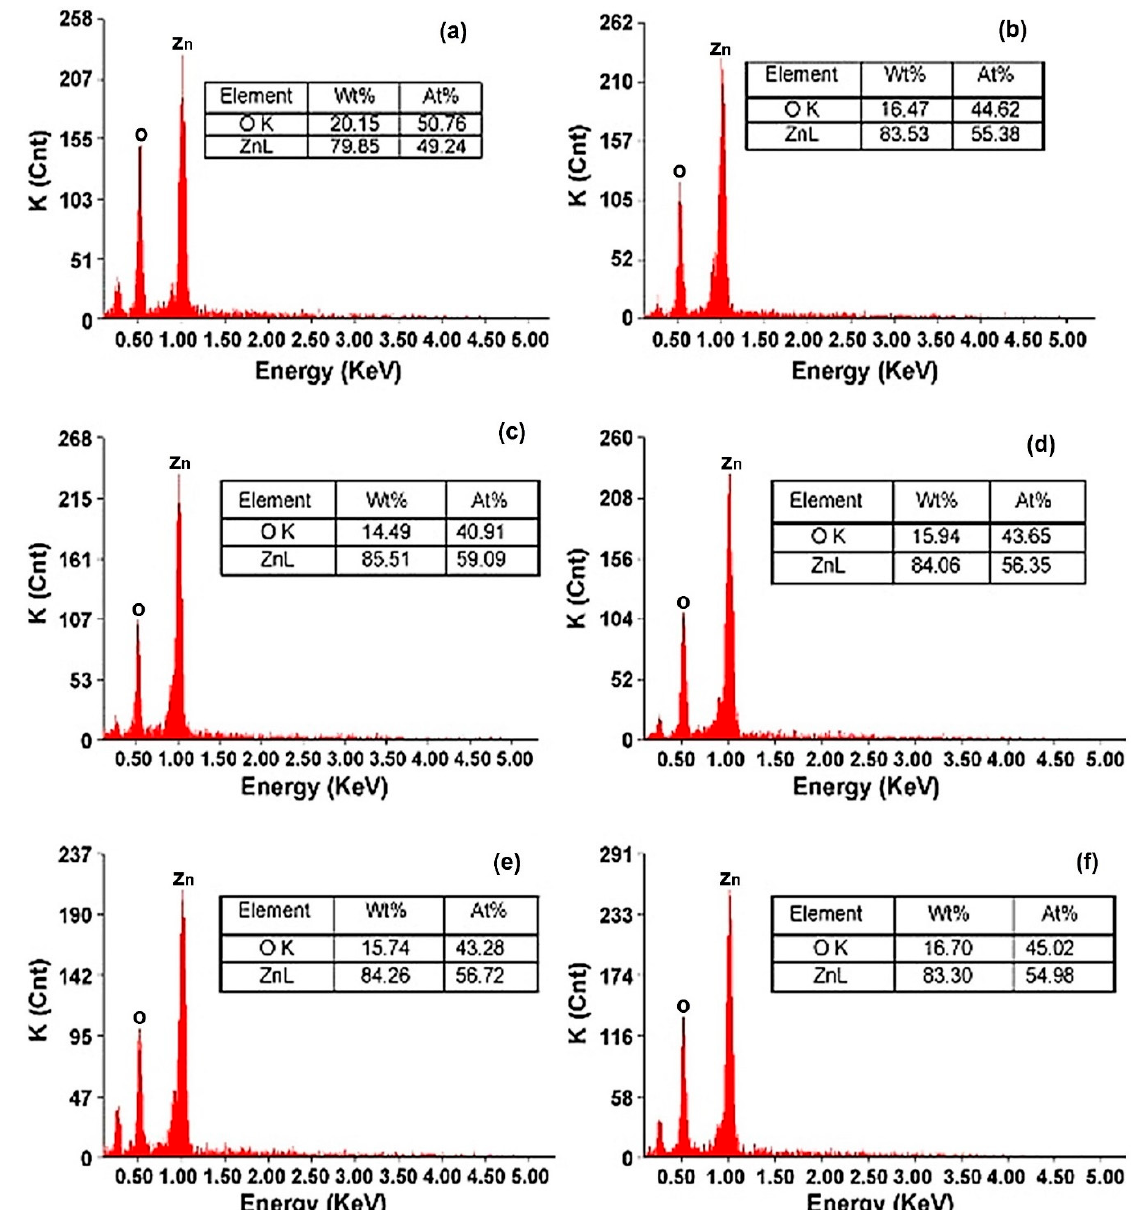
Figure 7. ( a – f ) Elemental detection spectroscopy (EDX) analysis of sol-gel synthesised nZnO at varies pH from 6 to 11, respectively. Reprinted with permission from Reference [65]. Copyright 2010, with permission from Elsevier.